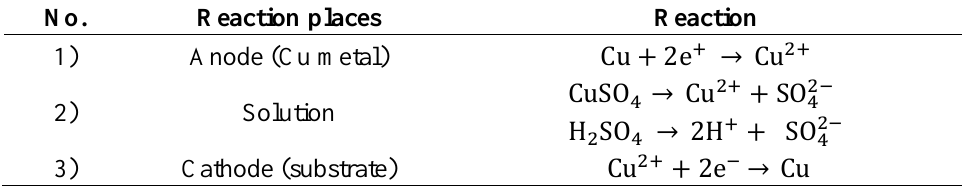
Table 3. Reactions taking place at anode (Cu), electrolyte solution (H cathode